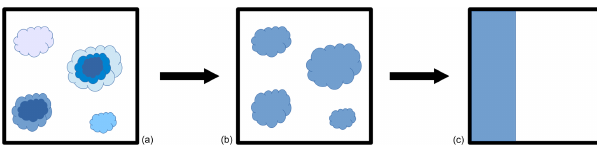
Figure 4. (a) A horizontal cross section of LES cloud field. (b) Derived “homogenized” cloud field, which retains its 3-D geome- try but where horizontal heterogeneity is completely removed by applying averaged cloud optical properties in each vertical layer. (c) Conditions in a grid box of a conventional GCM (homogeneous fractional